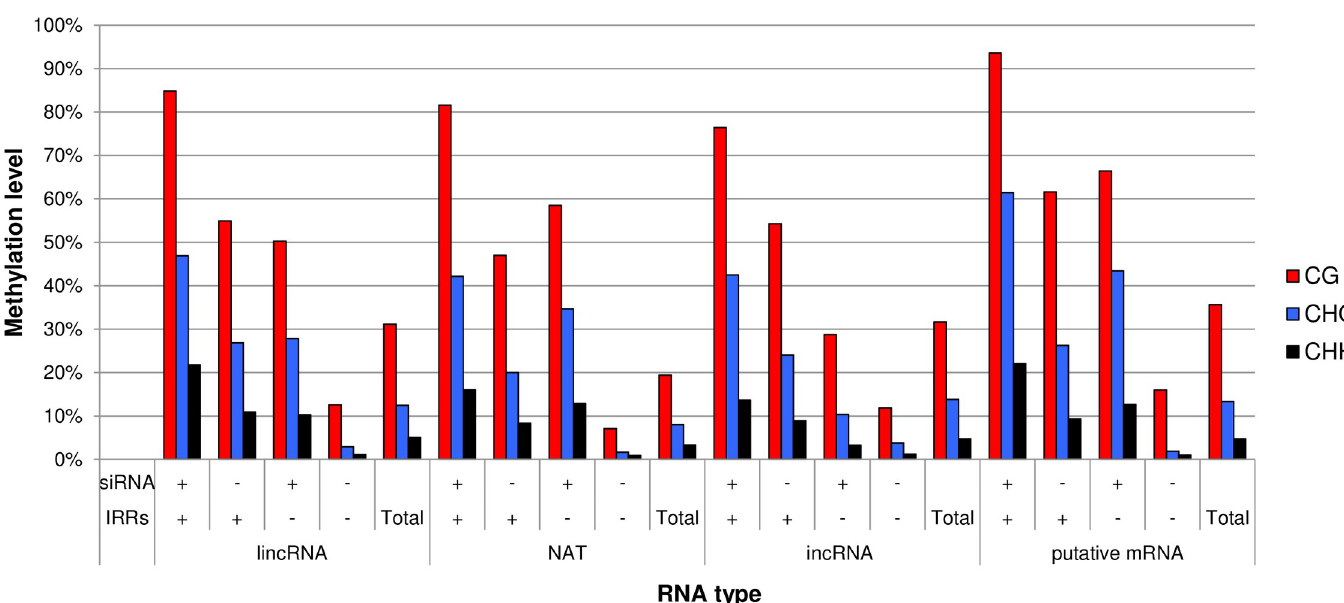
Fig 4. DNA methylation level of genomic regions encoding each RNA type with siRNAs or IRRs. “+” indicates with and “-” indicates without overlapping genomic regions encoding for siRNAs or IRRs.